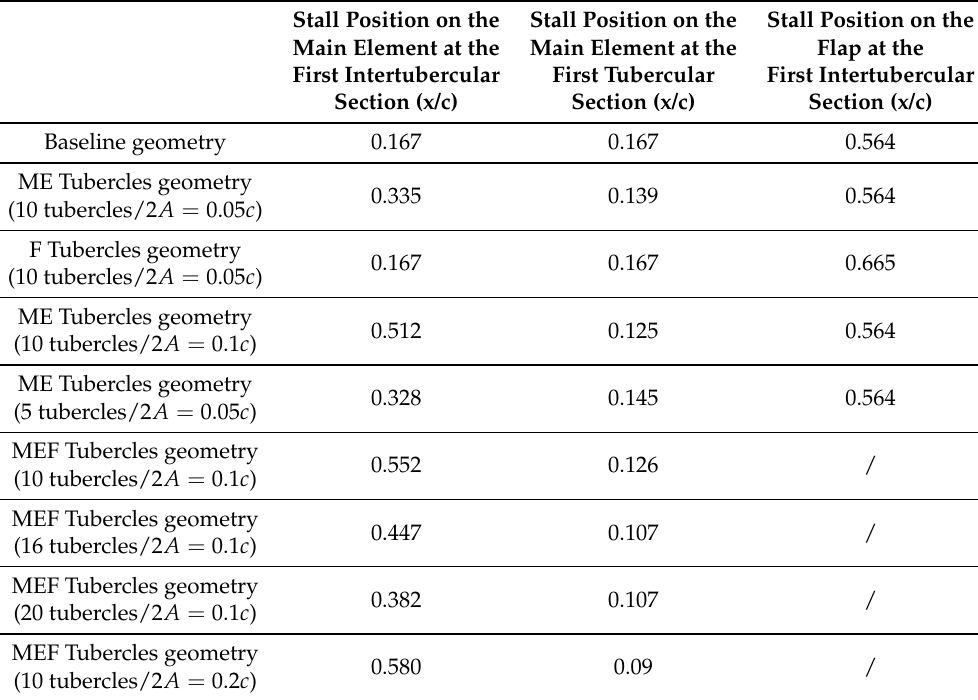
Table 8. Main characteristics of the separated flow over the front wing Part